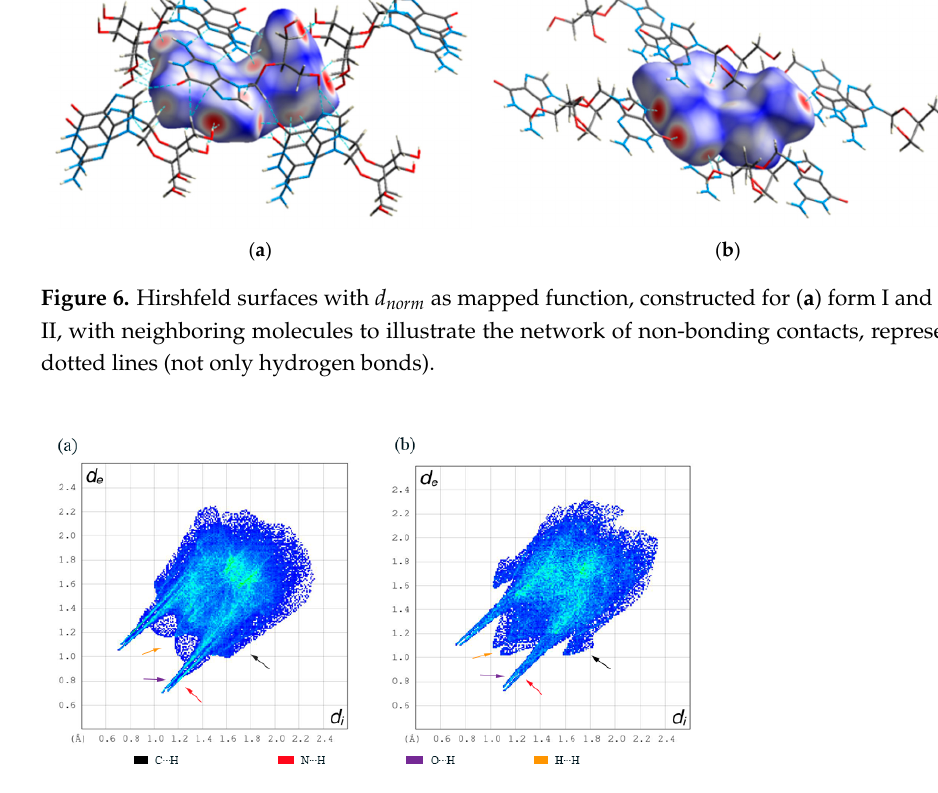
Figure 7. Fingerprint plots of ( a ) form I and ( b ) form II. The arrows represent interactions between different atoms, as indicated in the legend below. Given that the plots are approximately symmetrical, the arrows can be mirrored through the x–y diagonal.